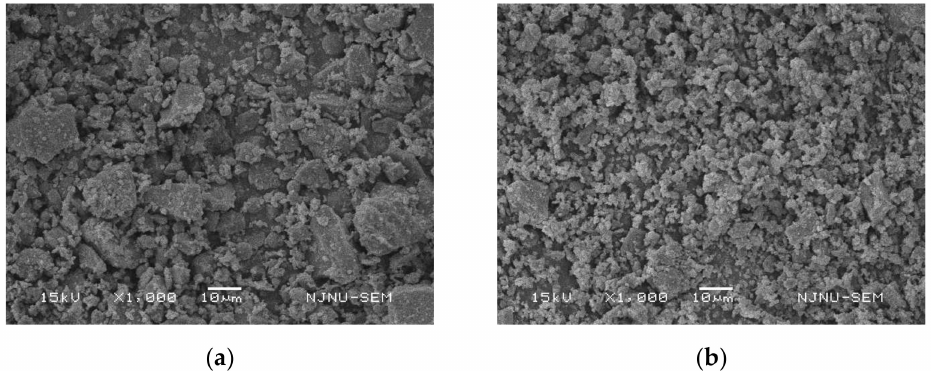
Figure 10. Microscopic photographs of limestone mineral powder and MIRP: ( a ) Limestone mineral powder; ( b ) MIRP.